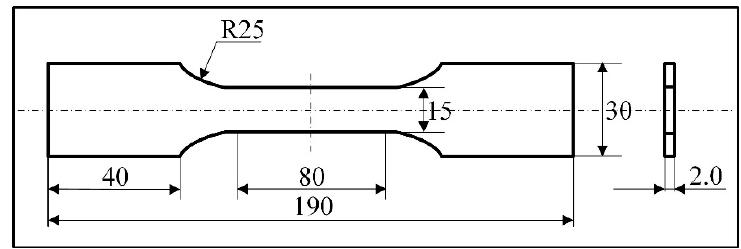
Figure 2. Schematic of the tensile sample (mm).